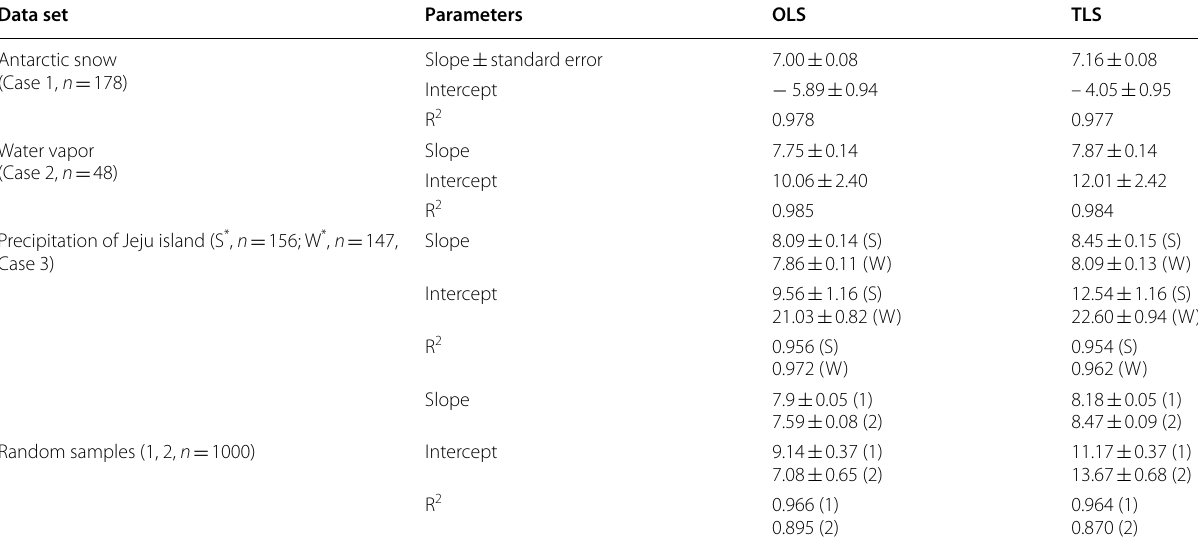
* S and * W denote summer and winter, respectively